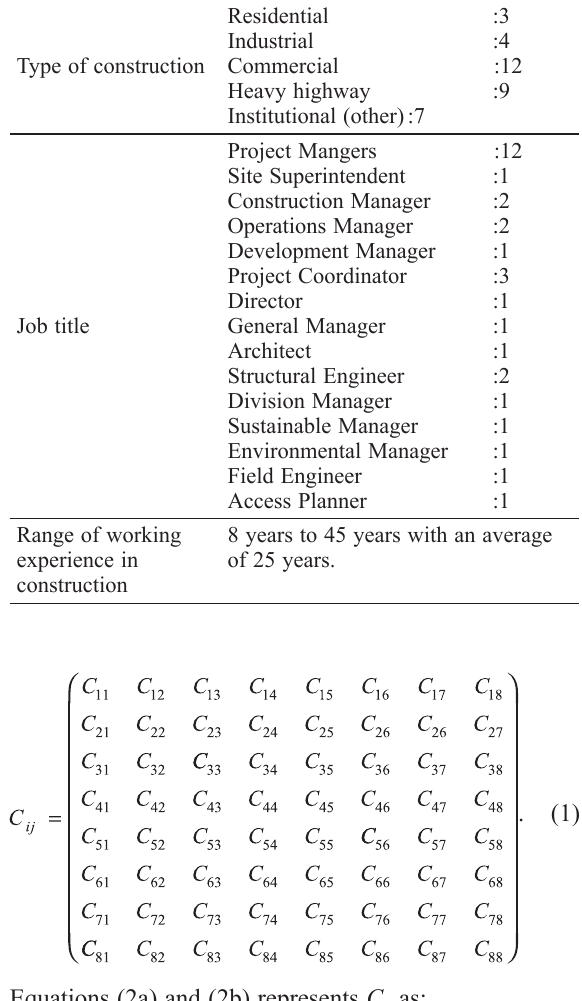
Table 2. Demographic information of the participants whose answers passed the consistency Factor Number